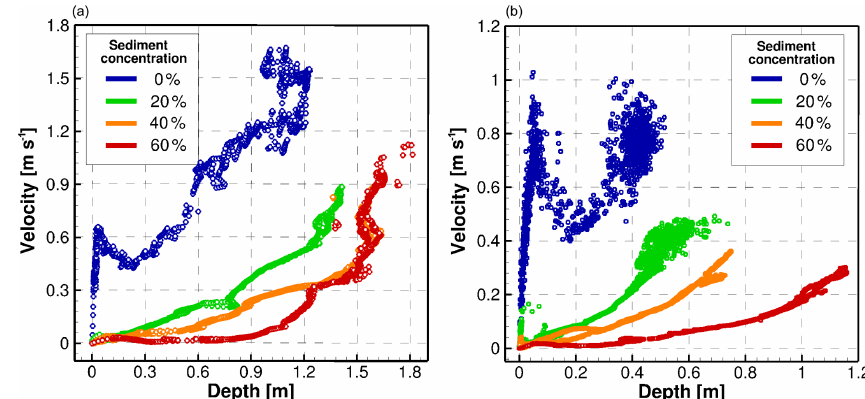
Figure 12. Stage–velocity relation between the computed flow depths and velocities for different sediment concentrations. The data at the point QR-U are shown in panel (a) and Qui-U in panel (b)